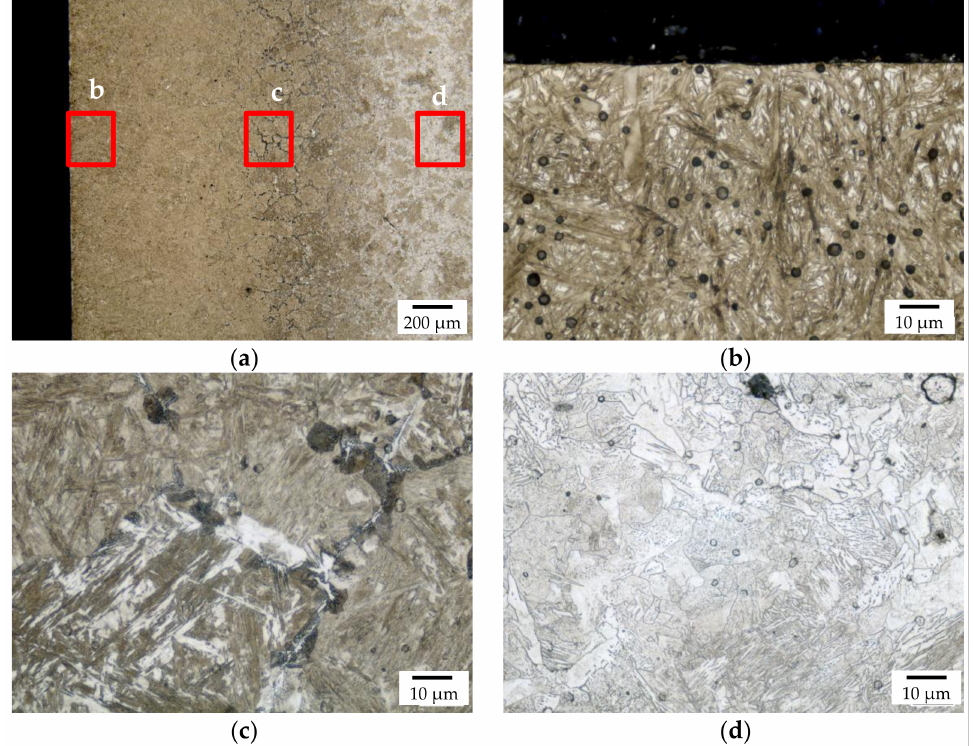
Figure 4. Detailed view of the polished section of the carburized sample without hollow spheres with ( a ) showing the overview of the case, ( b ) showing the surface near layer, ( c ) showing the transition zone at the case hardening depth CHD, and ( d ) showing the core microstructure.